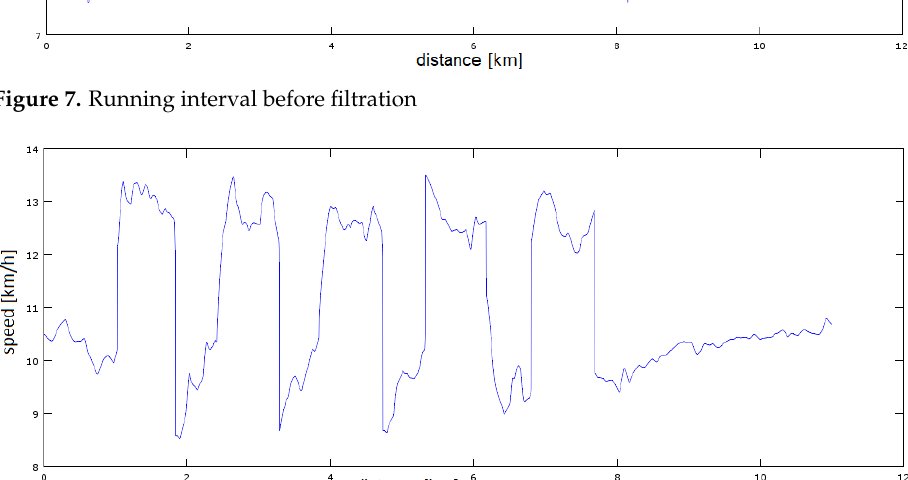
Figure 8. Running interval after